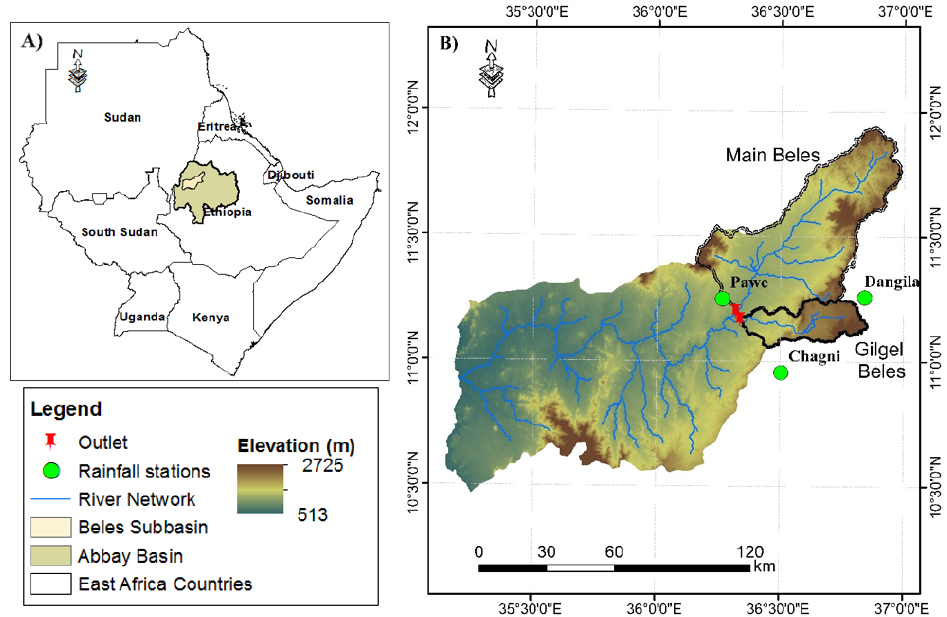
Figure 1. Location of the study area, river network, and rainfall gauging stations: ( A ) location of the Blue Nile and Beles Basin in East Africa and Ethiopia; and ( B ) river network of Main and Gilgel Beles and rainfall gauging stations with 30 m resolution Digital Elevation Model (DEM) as a background.